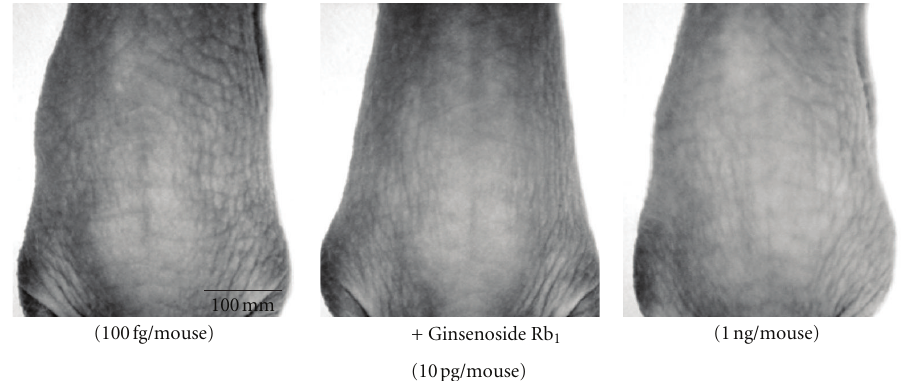
Figure 11: Photograph showing skin wrinkling induced by chronic UVB irradiation and the e ff ects of topically applied ginsenoside Rb 1 [31]. The experiments were performed as described in Figure 9. To evaluate the formation of wrinkles after the UVB irradiation, the UVB- irradiated dorsal area (site of wrinkles) of each hairless mouse was photographed at 9 weeks.